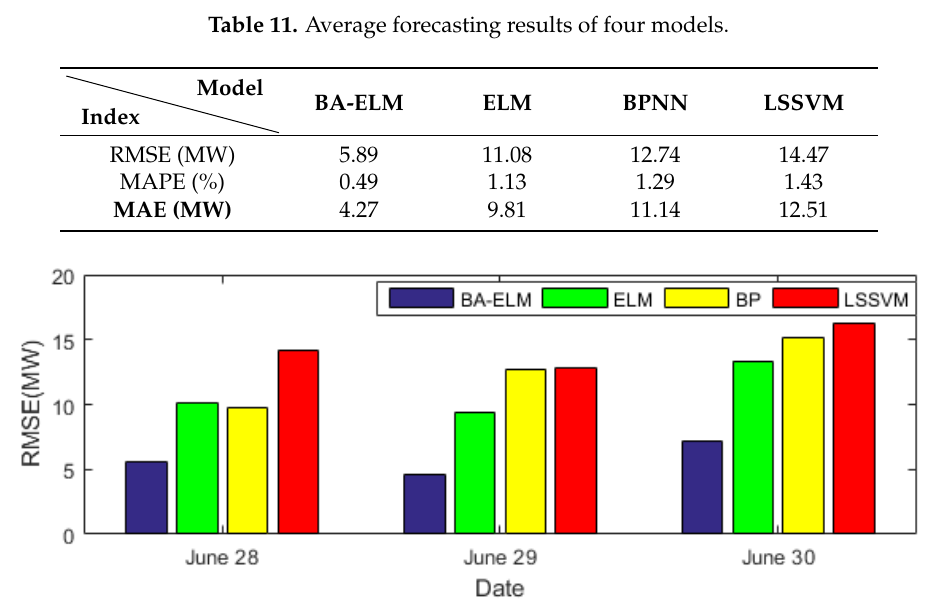
Figure 14. Root-mean-square error (RMSE) of different models in testing period.